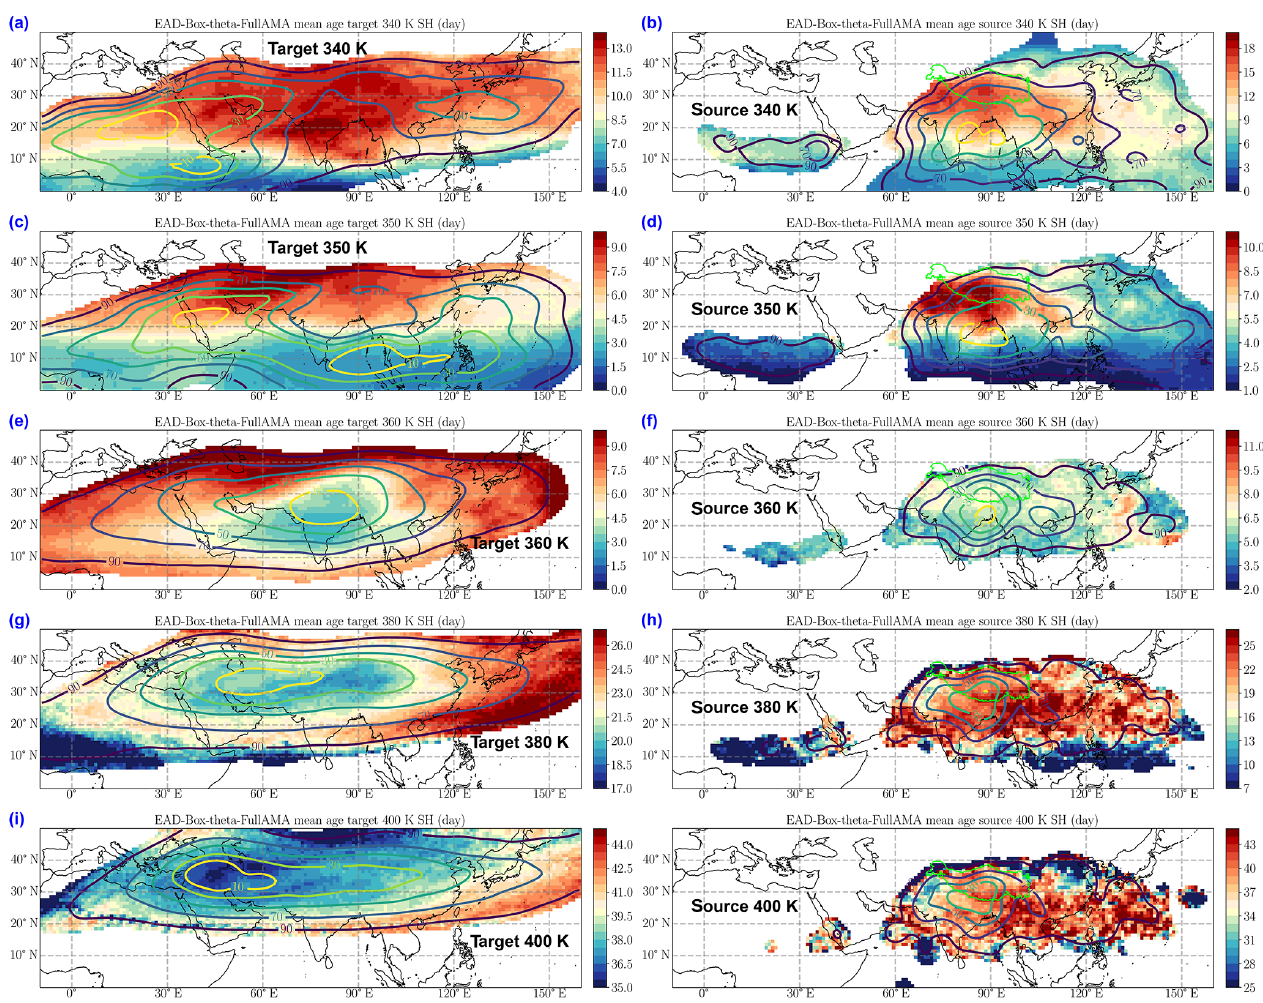
Figure 10. Left column (a, c, e, g, i) : mean age (in d) with respect to convection for forward parcels reaching the levels 340K (a) , 350K (c) , 360K (e) , 380K (g) and 400K (i) . Right column (b, d, f, h, j) : mean age in the source domain for the same parcels as in the left column for each level. The contours show the impact distribution at the same level and the fields are clipped outside of the contour that contains 95% of the cumulated impact. The results are shown for the ERA5 forward diabatic trajectories (EAD)